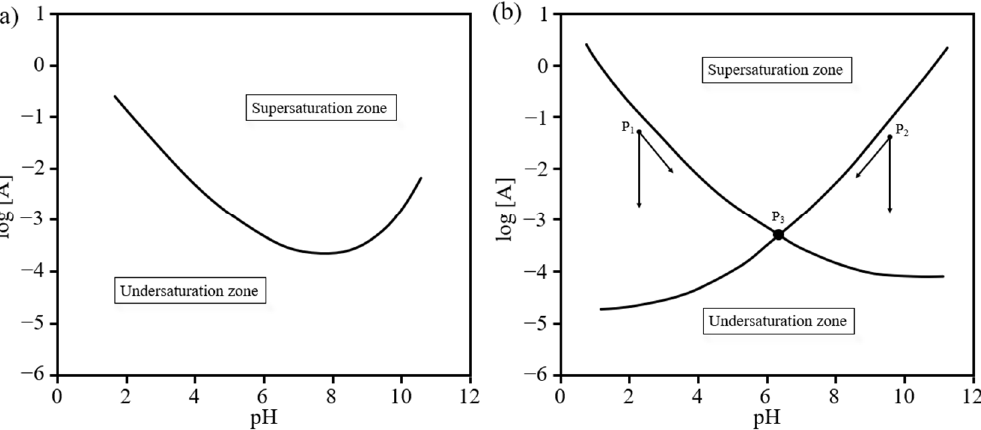
Figure 5. Solubility diagram of a general mineral compound ( a ) and the relative position of isotherms of two hypothetical compounds in the system ( b ). log [A] is the ion concentration of hypothetical compound A, pH—pH of the solution [85].